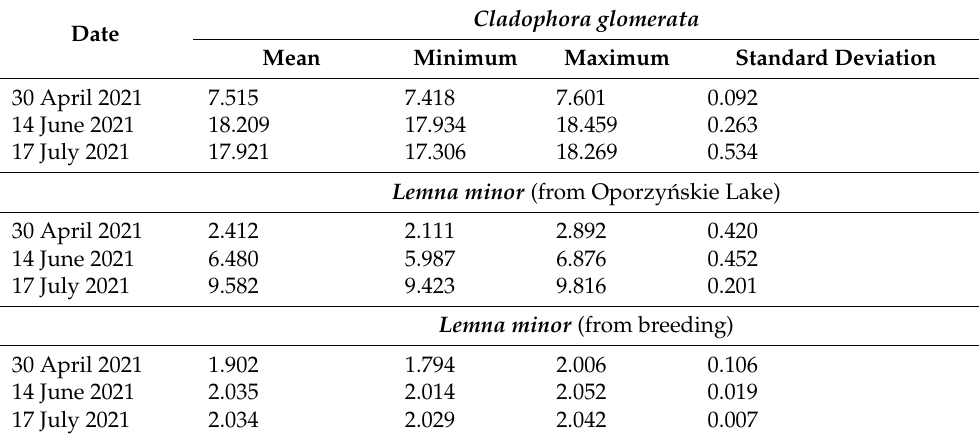
Table 9. The mean value, the minimum value, the maximum value, and the standard deviation of phenol concentration of C. glomerata from Oporzy´nskie Lake, L. minor from Oporzy´nskie Lake, and L. minor from breeding (mg GAE g − 1